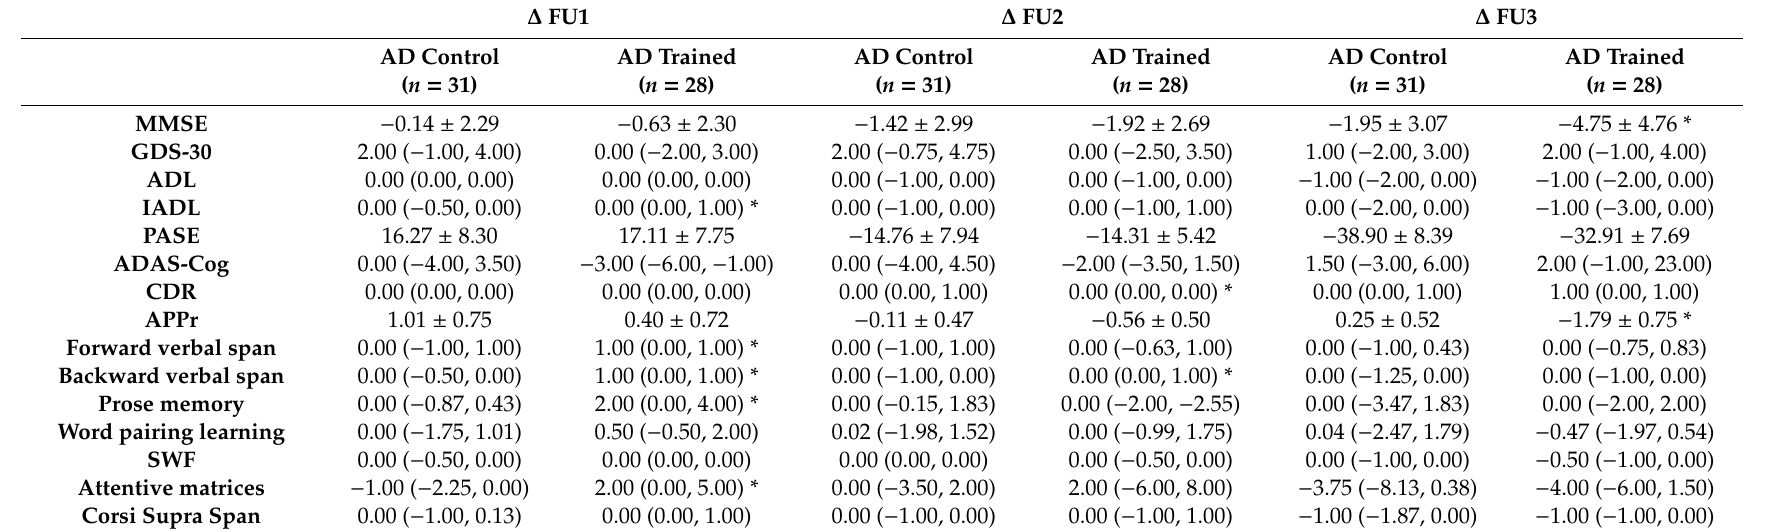
Table 3. Di ff erences between follow-up and baseline scores / values of the clinical variables in control and treated patients with AD. ∆ FU1 ∆ FU2 ∆